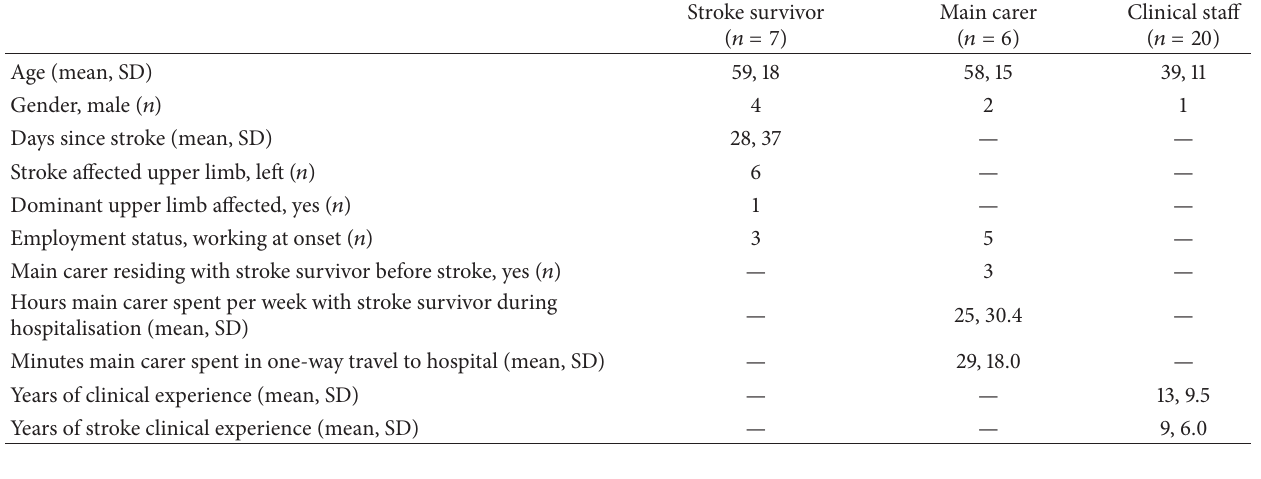
Table 2: Participant demographic details by